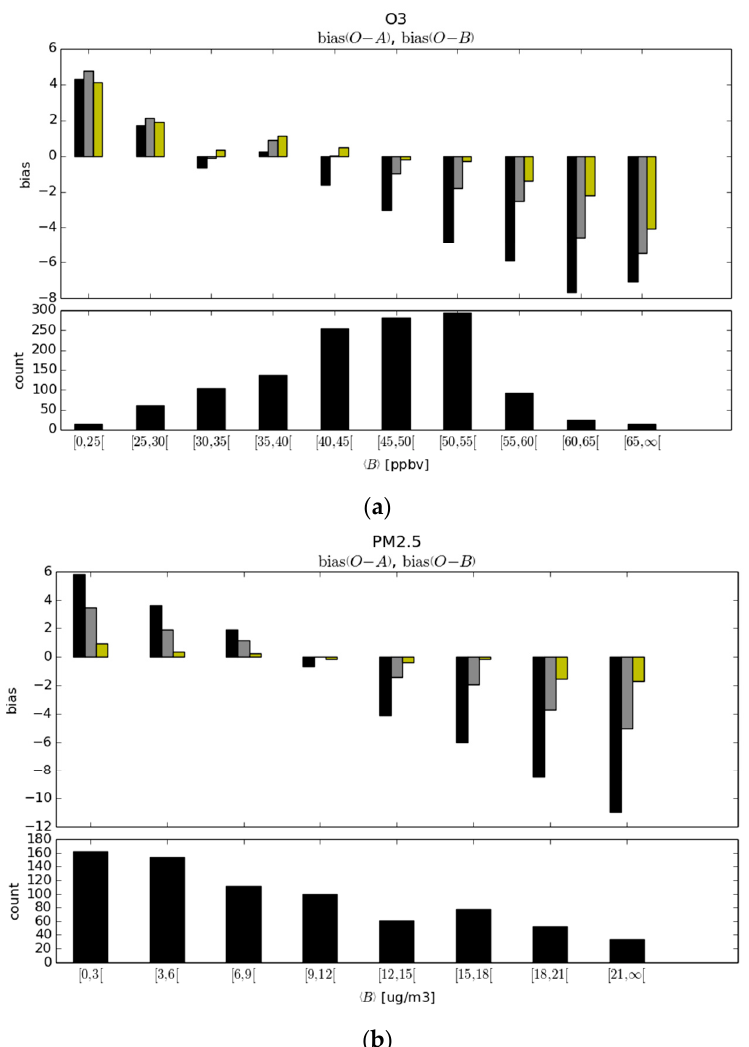
Figure 6. Biases per bin of model values. Figure ( a ), presents the statistics for O 3 and in ( b ), for PM 2.5 . In the upper portion, ( a , b ) are the residual statistics per bin; in black, the ( O − B ) , in grey, the ( O − A ) at passive observation sites (mean of the 3-fold subsets) for a non-optimal analysis with γ = 10, and in yellow, the ( O − A ) at passive observation sites (mean of the 3-fold subsets) using the optimal observation weight. In the lower portion, ( a , b ) are the station number count per model values.